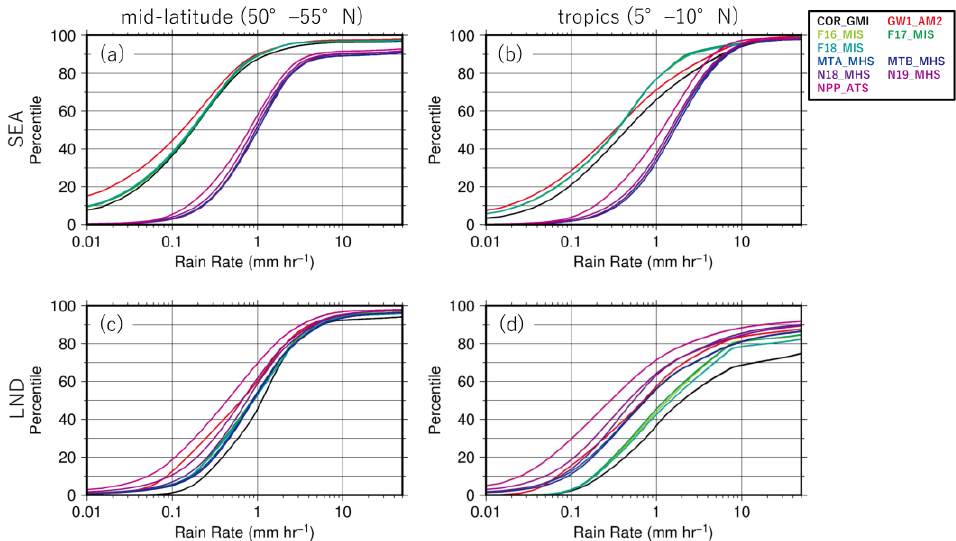
Figure 2. Cumulative distribution function of rainfall in July 2014 in ( a ) 50° – 55°N and ( b ) 5° – 10°N over ocean. ( c , d ) are the same as ( a , b ) except for over land.